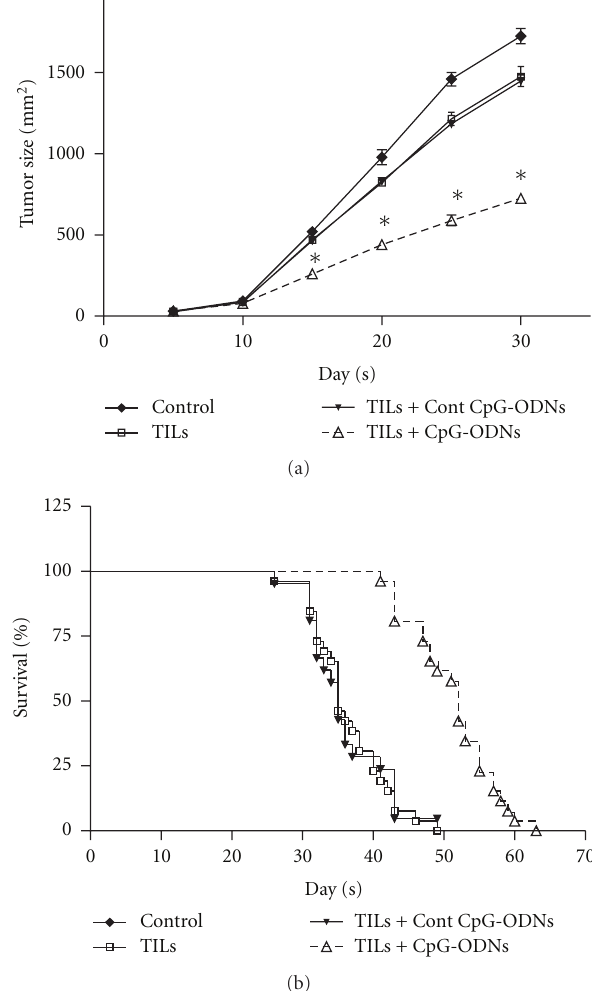
Figure 1: CpG-ODNs treated TILs reduced tumor burden and prolonged nude mice survival. TILs were collected from lung cancer patients ( n = 26) and treated with CpG-ODNs or control CpG- ODNs as described in Materials and Methods . 1 × 10 7 autologous TILs were transferred into lung cancer bearing Balb/c nude mice with 100ug CpG-ODNs or control CpG-ODNs through tail vein. The tumor growth of each group was measured and the survival time of tumor bearing nude mice was calculated. One representative data from 26 individual patients with lung cancer was shown (a). Each bar represents the means ( ± SD) from 6 nude mice in each group. The survival rate from all 26 individual patients was also calculated (b). ∗ P < .